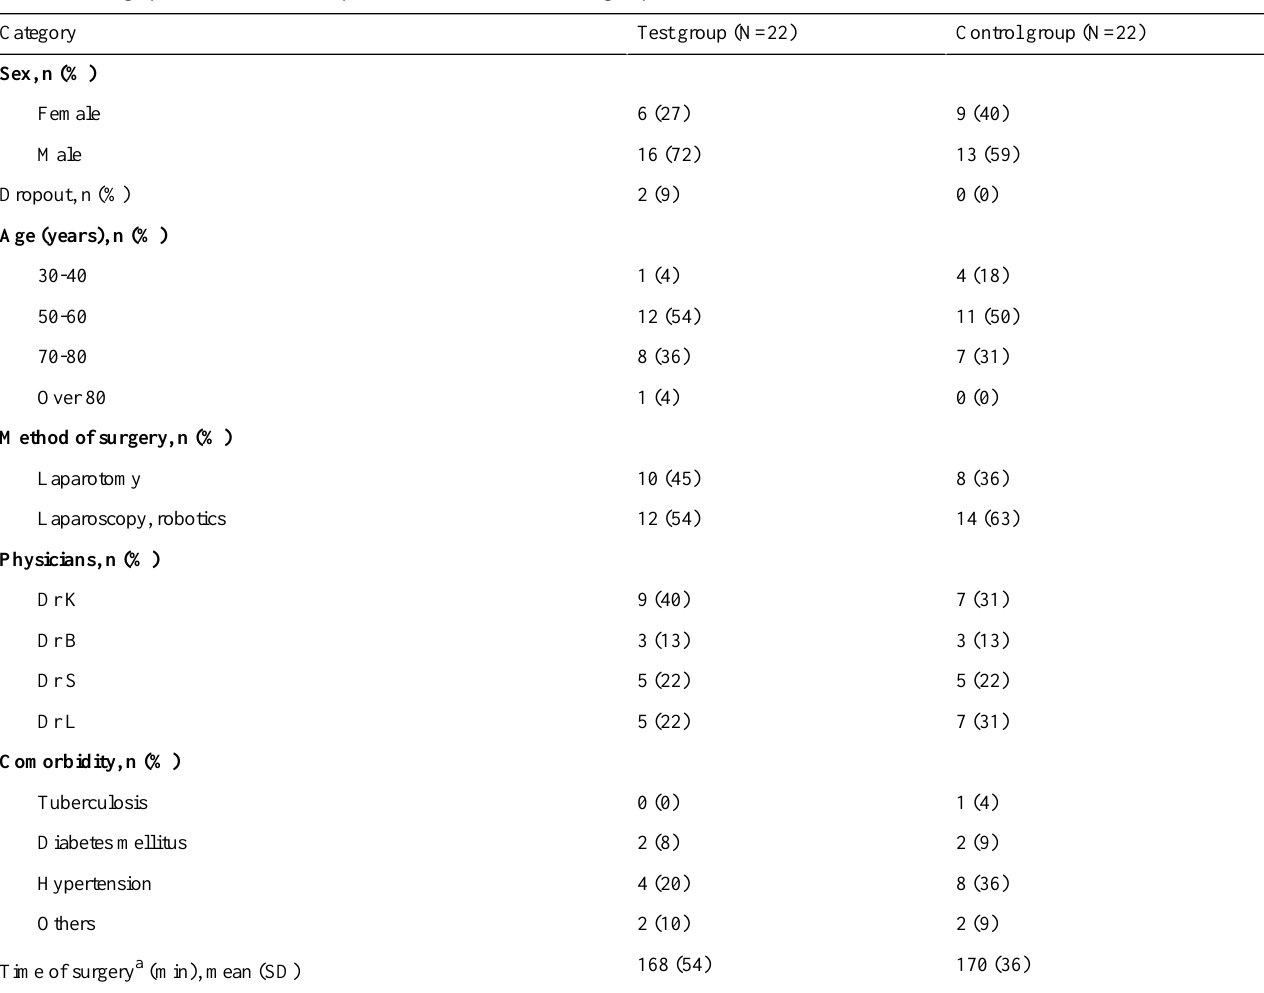
Table 1. Demographic characteristics of patients in the test and control groups.